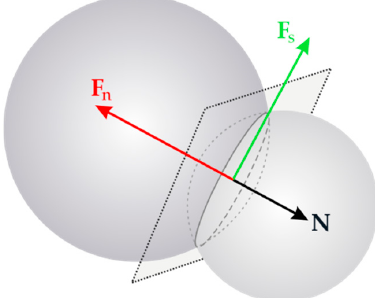
Figure 2. Two spheres in contact with the forces and momentum acting on them ( F n —normal contact force, F s —tangential contact force, and N —normal contact vector) [29].